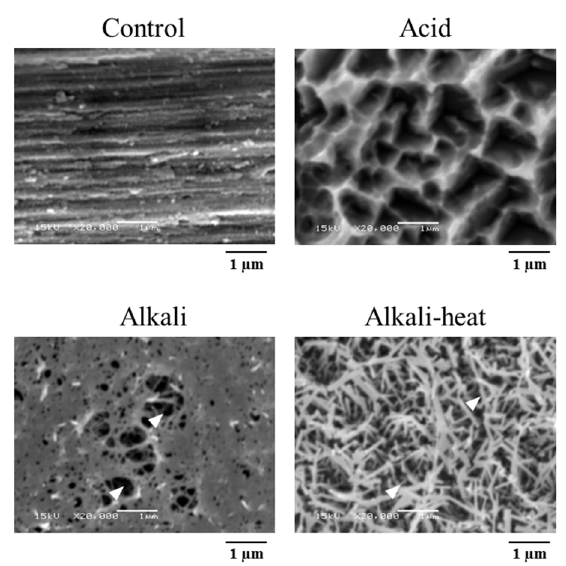
Figure 5. SEM images of the surface-treated Ti screw-type implants.